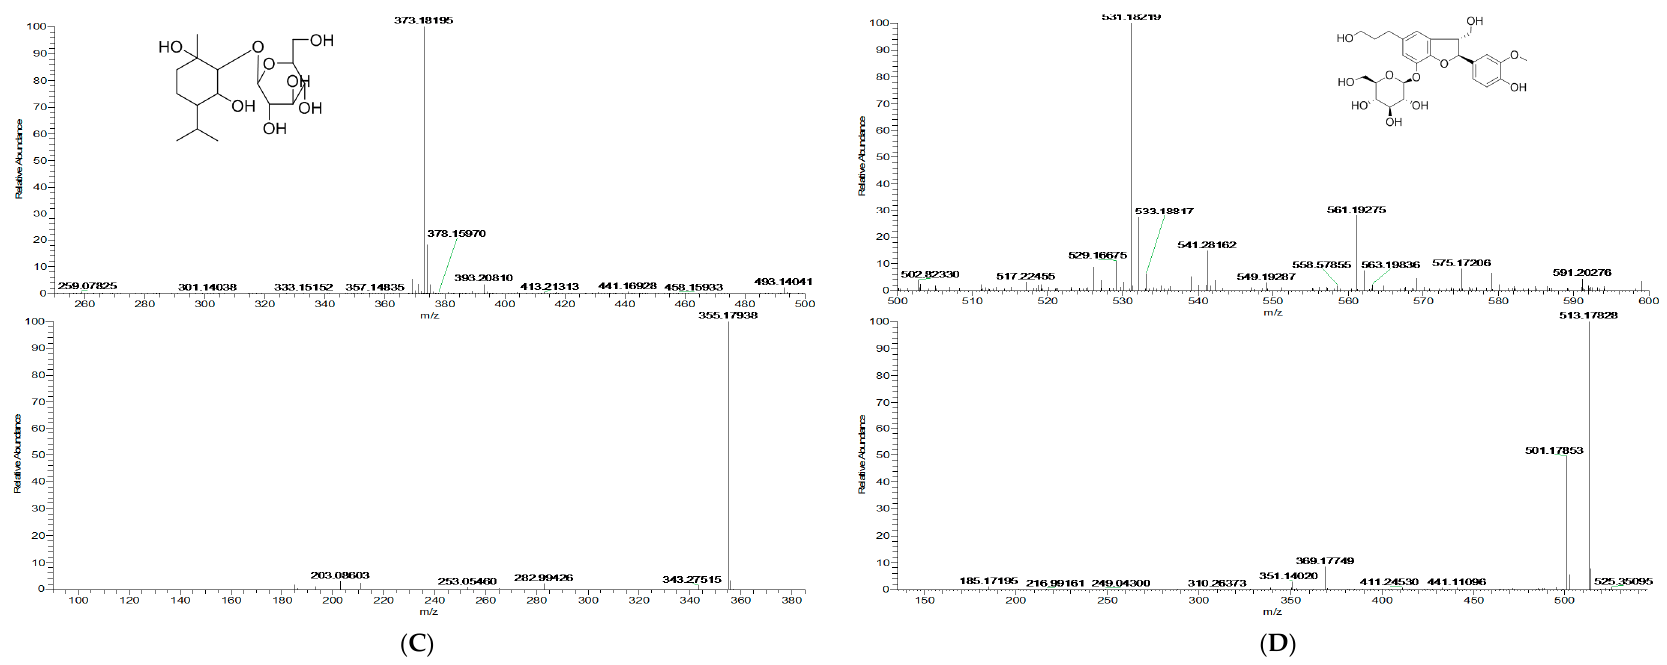
Figure 3. The representative mass spectra of chemical constituents identified in Menthae Haplocalycis herba in positive ion mode of Diosmin ( A ), Rosmarinic acid ( B ), Bohenoside A ( C ) and Clemastanin A ( D ).